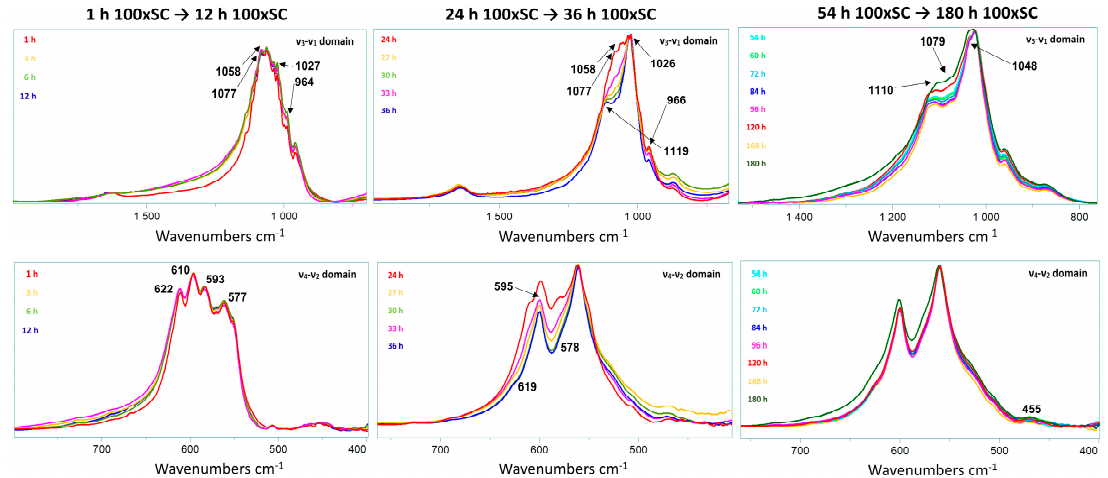
Figure 6. Raman spectra of the OCP formation as a function of time in 100 × SC. The graph displays a close up of ν 1– ν 4 stretching mode of the P–O vibration. Assignment of the highlighted bands can be found in Table S2.